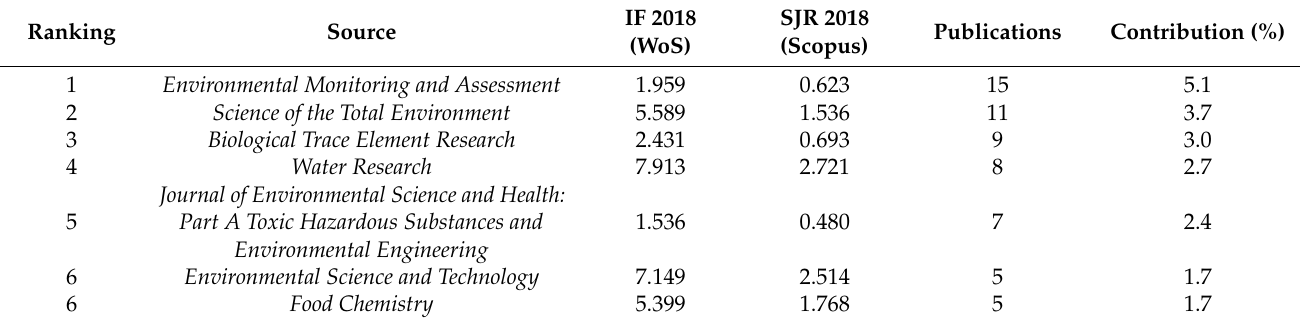
Table 5. The top seven most popular journals (at least five